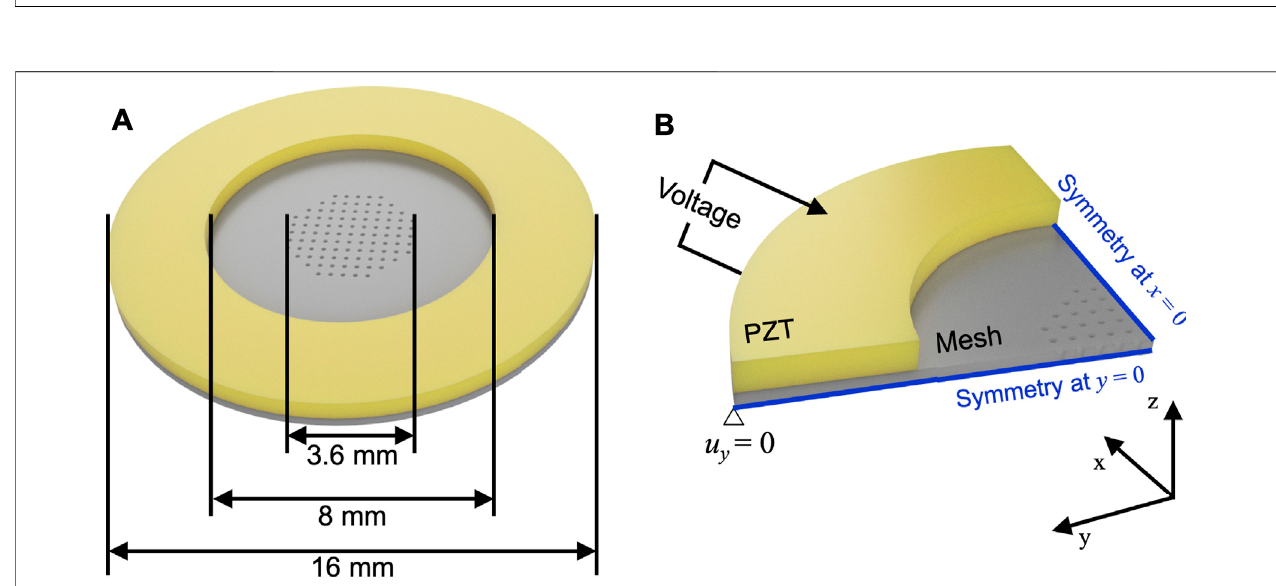
FIGURE 2 | (A) The schematic shows the dimension of the atomizer. (B) The image shows how the atomizer was modeled in ANSYS . The voltage was applied to the top and bottom layers of the piezoelectric ring.